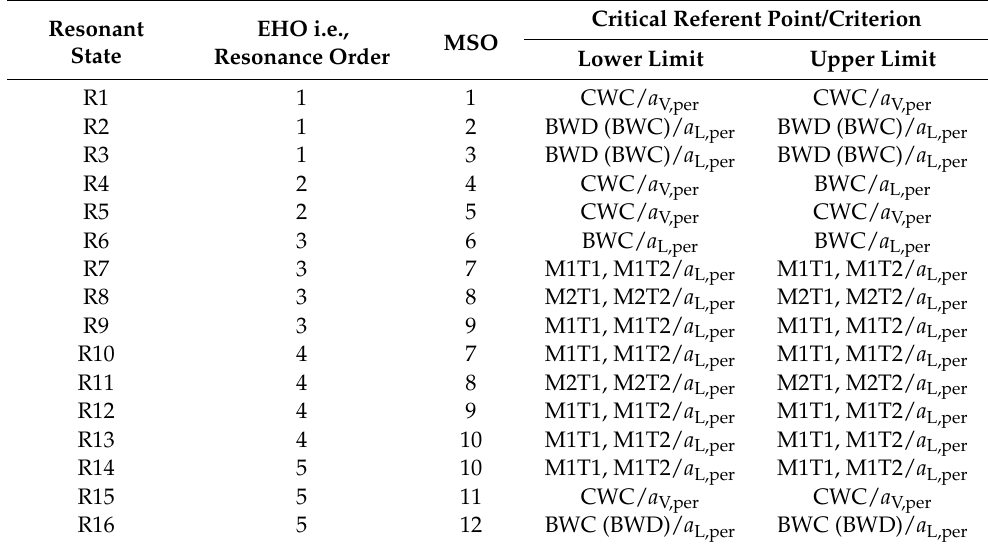
Table 15. Modal shape and resonance order vs. critical referent point/criterion. Critical Referent Point/Criterion Resonant EHO i.e., MSO State Resonance Order Lower Limit Upper